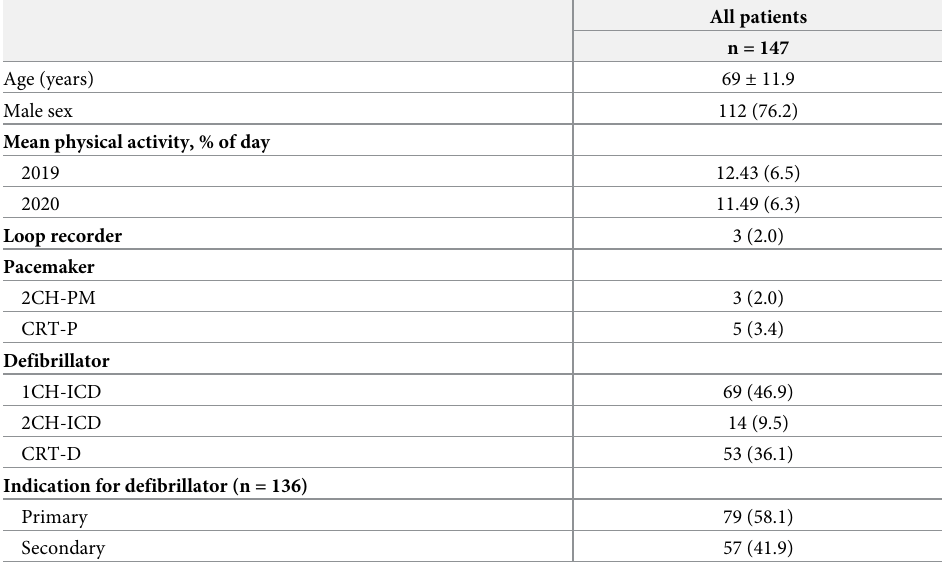
Table 1. Baseline